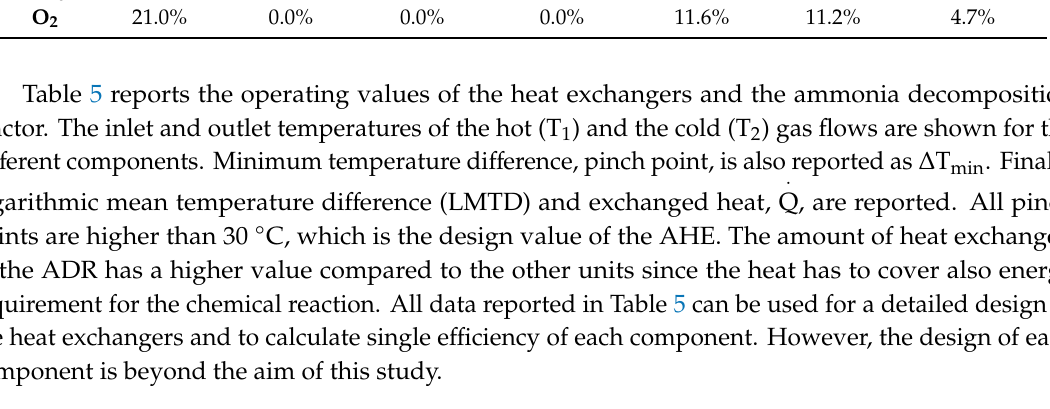
Table 5. Data of the heat